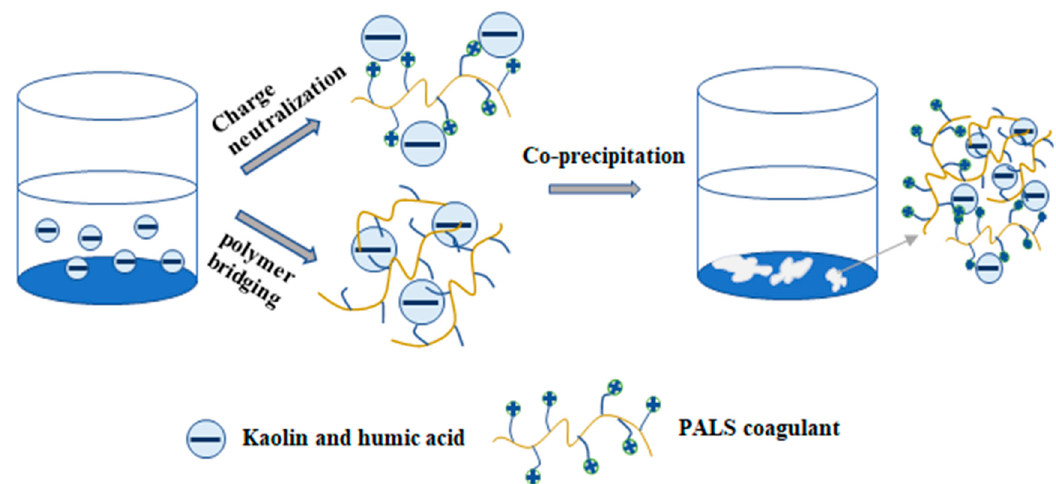
Figure 8. Schematic diagram of coagulation mechanisms.